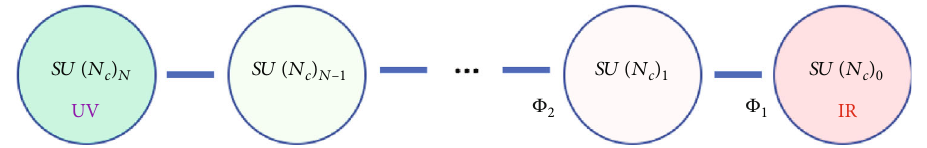
Þ lattice representation of Figure 5: SU ð N c